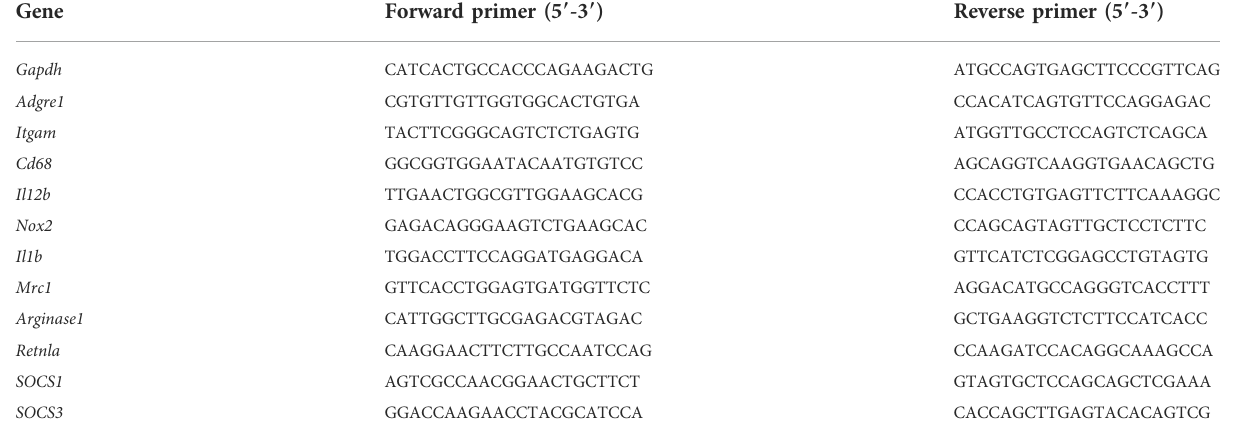
TABLE 1 The primer sequences used for qPCR assay in mice.